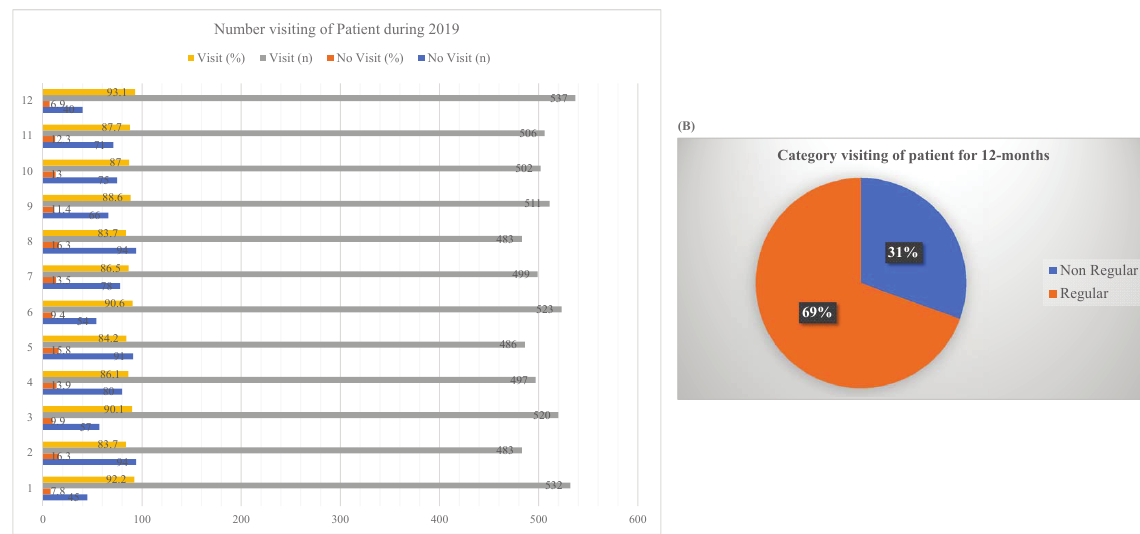
Figure 1. (A) Number of participants visiting during 2019 to Posbindu-NCD ( n = 577). (B) Category visiting of patient for 12 months to Posbindu-NCD ( n =